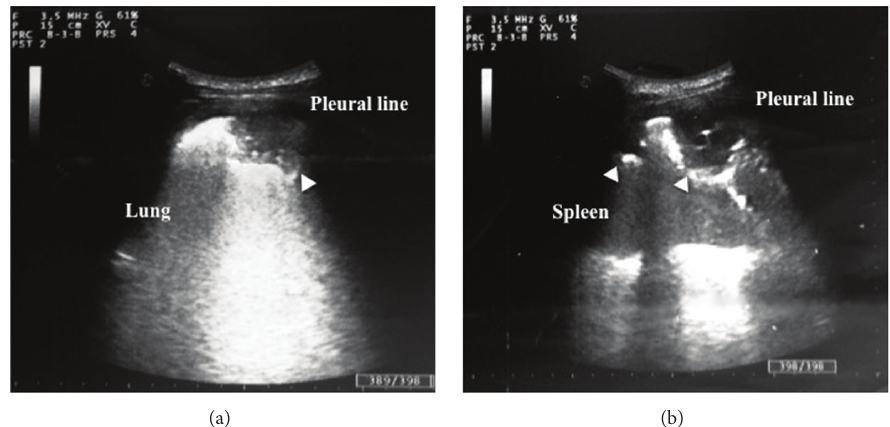
Figure 1: Chest sonography (3.5 MHz convex scanner): hypoechoic, wedge, and rounded shaped, subpleural consolidations (arrowheads) in the right (a) and left lung (b).